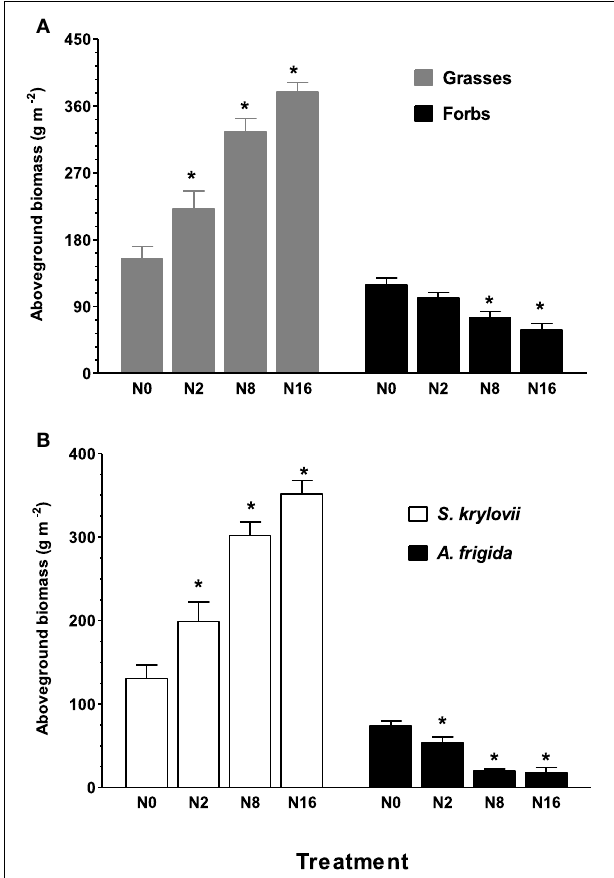
FIGURE 1 | Effect of N addition on aboveground biomass of grasses and forbs (A), and S. krylovii and A. frigida (B). Aboveground biomass was determined in quadrats ( 1 × 1 m). N0, N2, N8, and N16 represent N addition rate of 0, 2, 8, 16 g ha − 1 yr − 1 . Data are means ± s.e. ( n = 8 ). Asterisks on the top of columns indicate significant difference at P < 0 . 05 between N0 and different rates of N addition for each species.